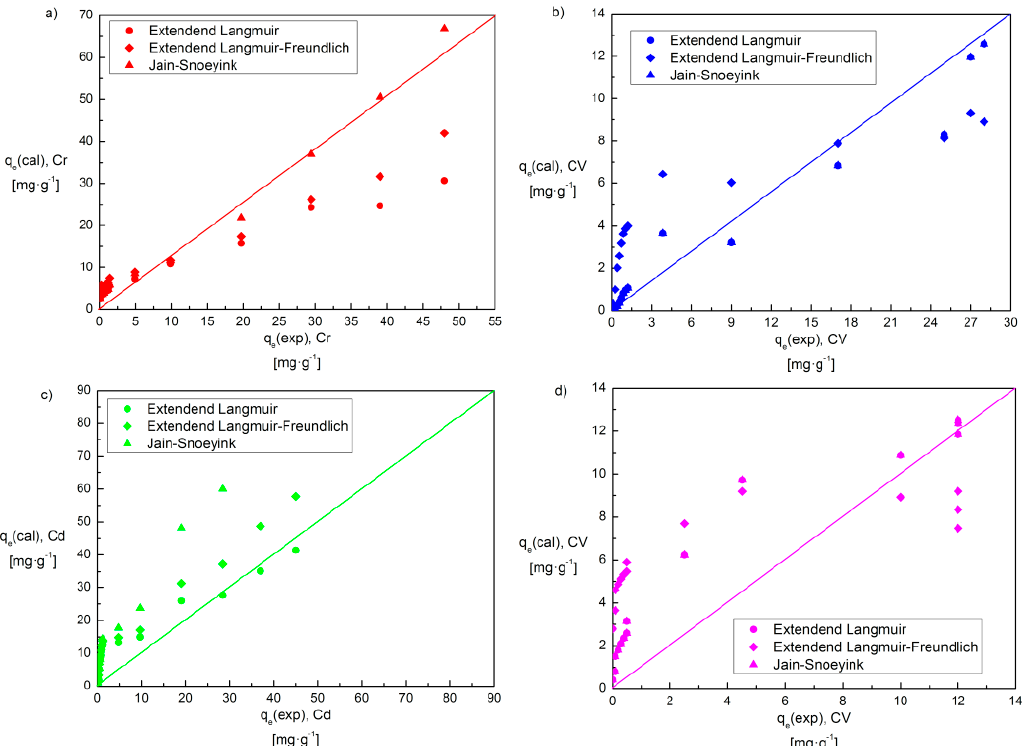
Figure 10. Scatter plot of estimated (cal.) vs. experimental (exp.) values for the equilibrium sorption capacity using the Extended Langmuir (EL), Extended Langmuir–Freundlich (ELF), Jain–Snoeyink (JS) isotherm models ( a ) qe (cal) Cr(III) vs. qe (exp) Cr(III) in the Cr(III)–CV system ( b ) qe (cal) CV vs. qe (exp) CV in the Cr(III)–CV system ( c ) qe (cal) Cd(II) vs. qe (exp) Cd(II) in the Cd(II)–CV system ( d ) qe (cal) CV vs. qe (exp) CV in the Cd(II)–CV system.